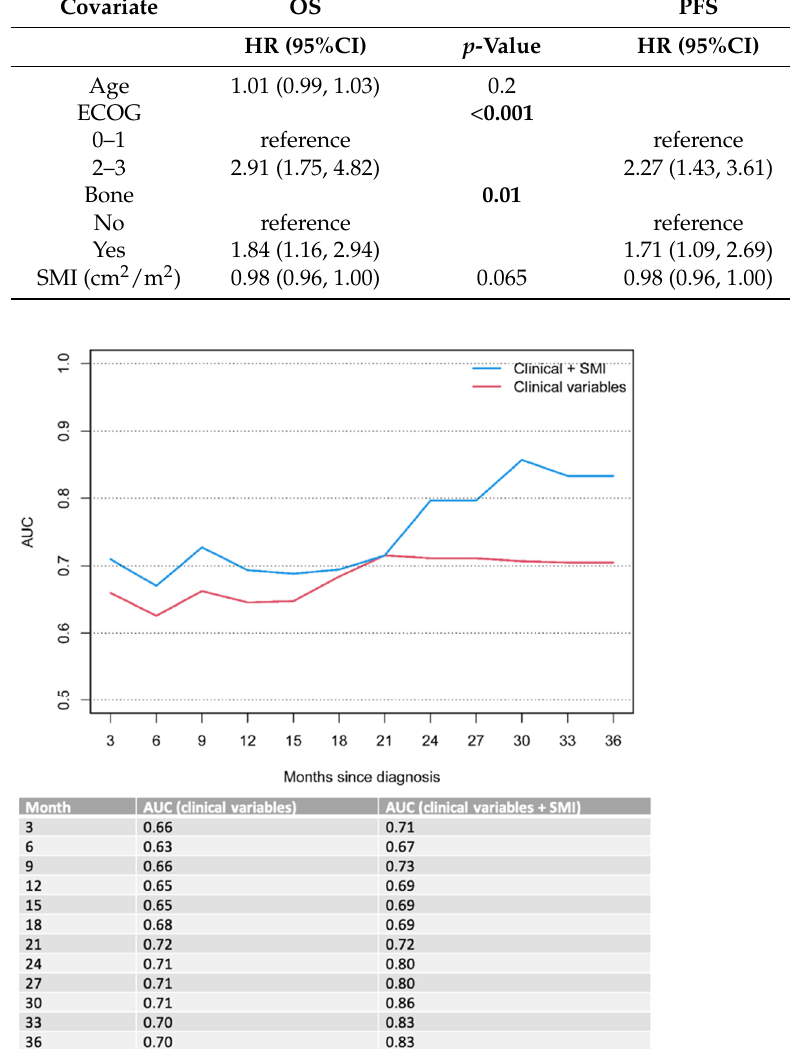
Figure 3. Time-dependent AUC for PFS. Clinical variables include ECOG performance status and bone metastases.